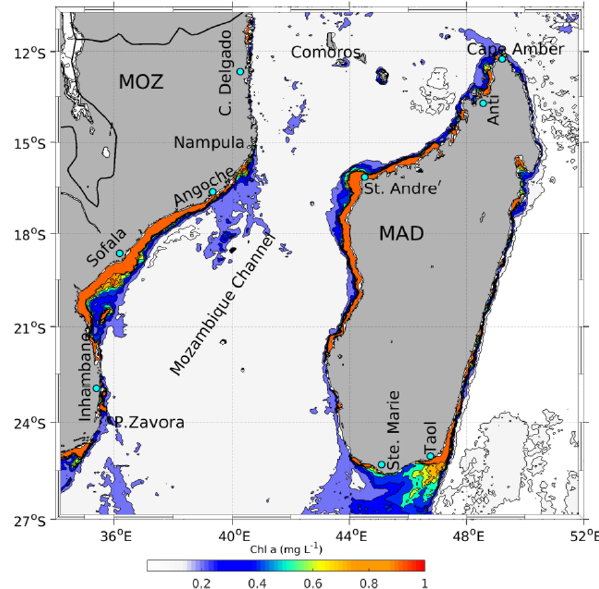
Figure 10. Monthly mean chlorophyll a concentration for Febru- ary 2003, derived from the Moderate Resolution Imaging Spectro- radiometer (MODIS) aboard the Aqua satellite (https://oceancolor. gsfc.nasa.gov/data/aqua/, last access: 5 November 2021). Interme- diate values beyond the continental shelf edge highlight areas of elevated productivity off the Mozambique and Madagascar coasts that are primarily upwelling-driven. Abbreviations are Ponta Za- vora (P. Zavora), Cabo Delgado (C. Delgado), Taolagnaro (Taol), and Antsiranana